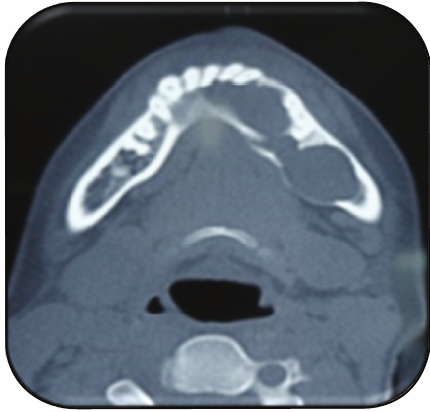
Figure 6: CT scan (axial view).